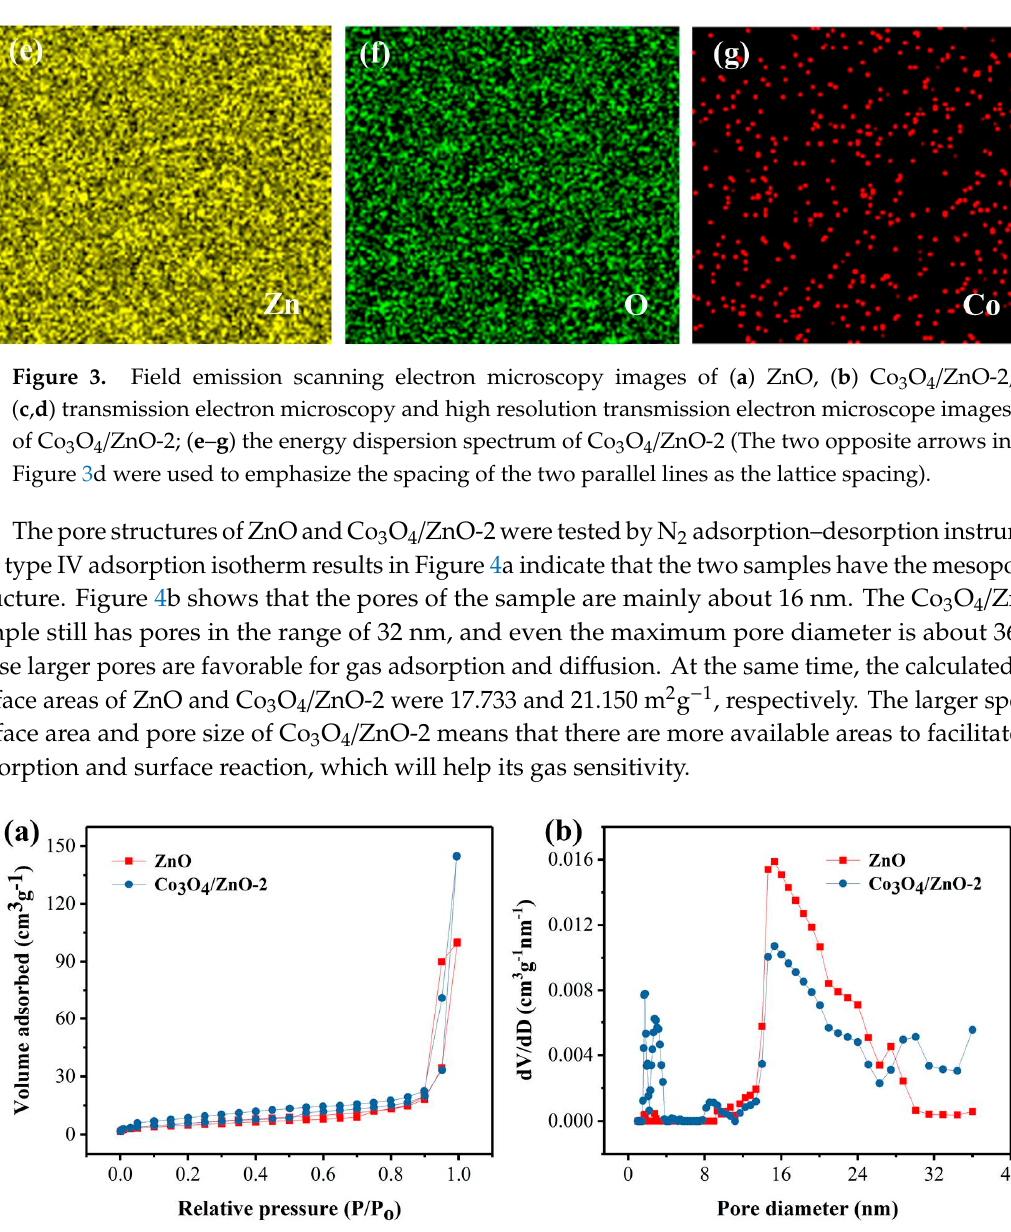
Figure 4. ( a ) N 2 adsorption–desorption isotherms and ( b ) pore size distribution curves of the prepared ZnO and Co 3 O 4 /ZnO-2 samples.